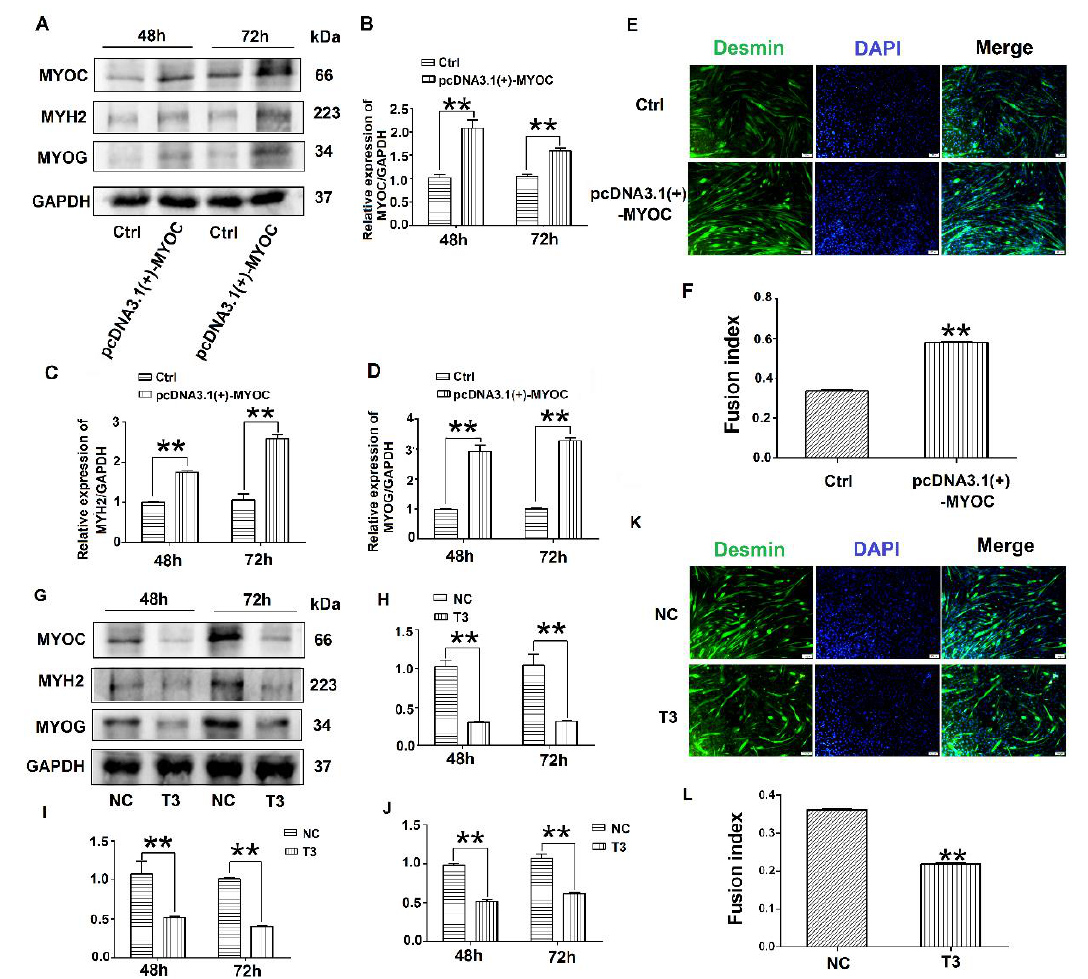
Figure 2. Influence of MYOC overexpression on the inhibition of C2C12 cell differentiation. ( A ). Protein expression of various molecules transfected with pcDNA3.1(+)-MYOC and the empty vector for 48 h and 72 h respectively. ( B ). Grayscale scans of MYOC in Figure A. ( C ). Grayscale scans of MYH2 in Figure A. ( D ), Grayscale scanning of MYOG in Figure A. ( E ). Comparison of fusion rate of myotubes after transfection with empty vector and overexpression vector 5 days later, Desmin stained in green and DAPI stained blue. ( F ). Figure E Statistics of myotubule fusion rate. ( G ). Protein expression of various molecules transfected with NC and T3 fragments for 48 h and 72 h, respectively. ( H ). Grayscale scans of MYOC in Figure G. ( I ). Grayscale scans of MYH2 in Figure G. ( J ). Grayscale scanning of MYOG in Figure G. ( K ). Fusion rate of myotubules 5 days after transfection with NC and T3 sequences. Green represents Desmin staining, blue DAPI staining. ( L ). Statistics of myotubule fusion rate in Figure K. (** p values < 0.01) ( n = 3).